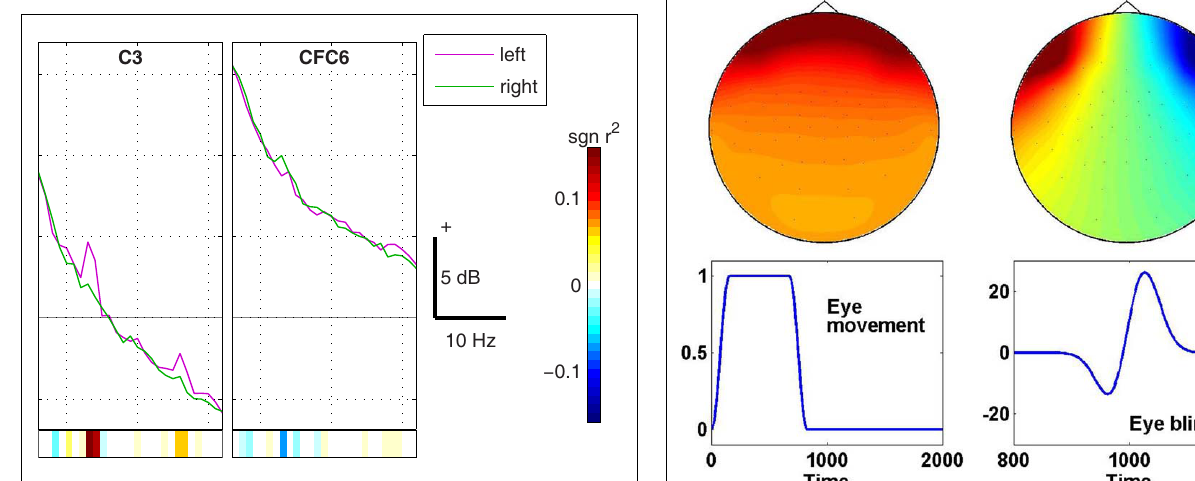
FIGURE 13 | (Data Set 1 – artificial). Top row: scalp plots of one eye movement and one eye blink generated for the synthetic EEG data sets of the BCI competition IV. Bottom row: corresponding time course of eye movements and blinks.